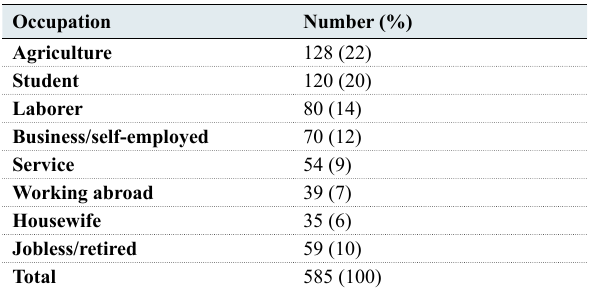
Table 1: Distribution of patients according to occupation